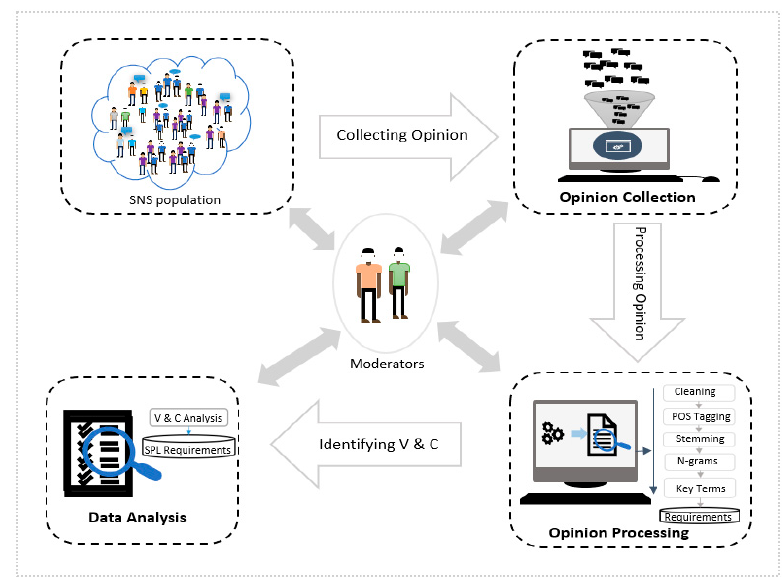
Figure 1. SNS-based RE Process . ( SNS: Social Network Services, RE: Requirements Engineering).